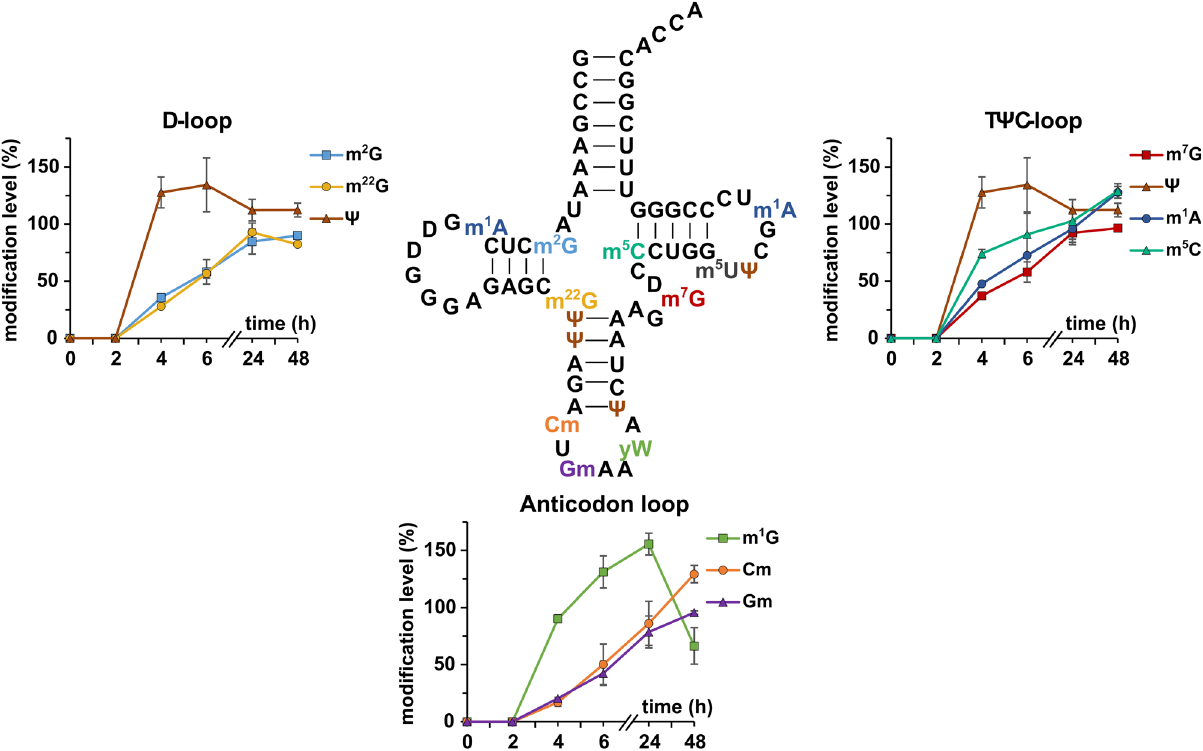
Fig. 4 Temporal placement of modi fi ed nucleosides in tRNA Phe GAA . Cells were grown in unlabeled DMEM D0422 (supplemented with unlabeled uridine and adenine) for 7 days. At T = 0 the medium was exchanged to DMEM D0422 supplemented with labeled uridine and adenine. Cells were harvested after set time points. tRNA Phe was puri fi ed and analyzed by LC-MS/MS. Modi fi cations are plotted next to their location in the D-, T Ψ C- or anticodon loop. Plotted on the y -axis is the abundance of modi fi cation in new transcripts normalized to the respective nucleoside originating from unlabeled medium before experiment initiation (T = 0). The experiment was done in n = 3 biol. replicates for time points 2, 4, and 48 h and in n = 6 biol. replicates for time points 0, 6, and 24 h. Symbols re fl ect the mean and error bars re fl ect standard